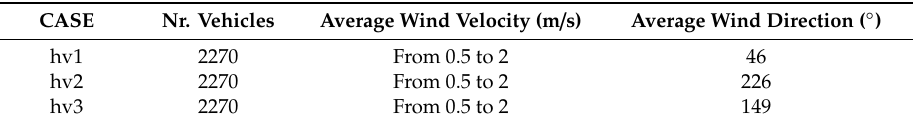
Table 3. Hypothetical cases (hv) with parallel and perpendicular wind